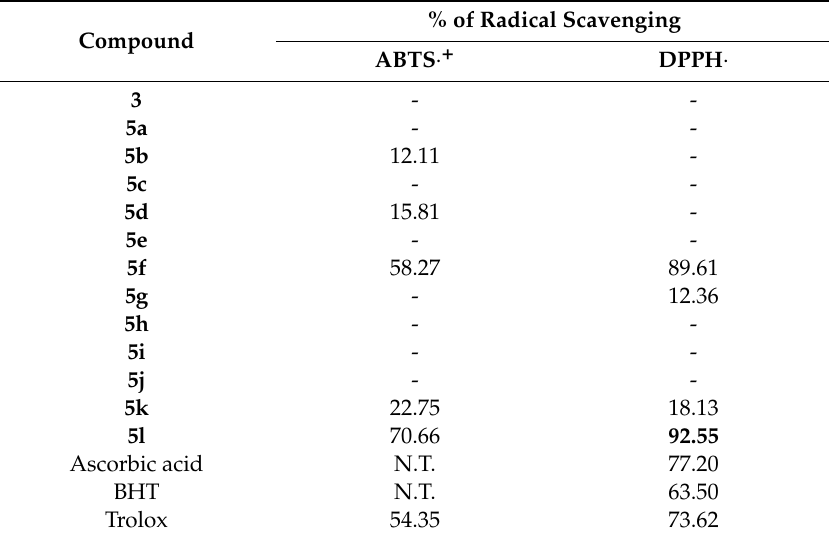
Table 1. Results of the ABTS · + and DPPH · scavenging